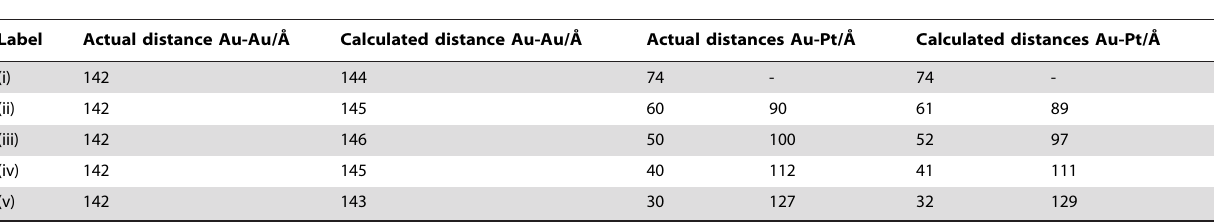
Table 3. Distances between nanocrystal labels.